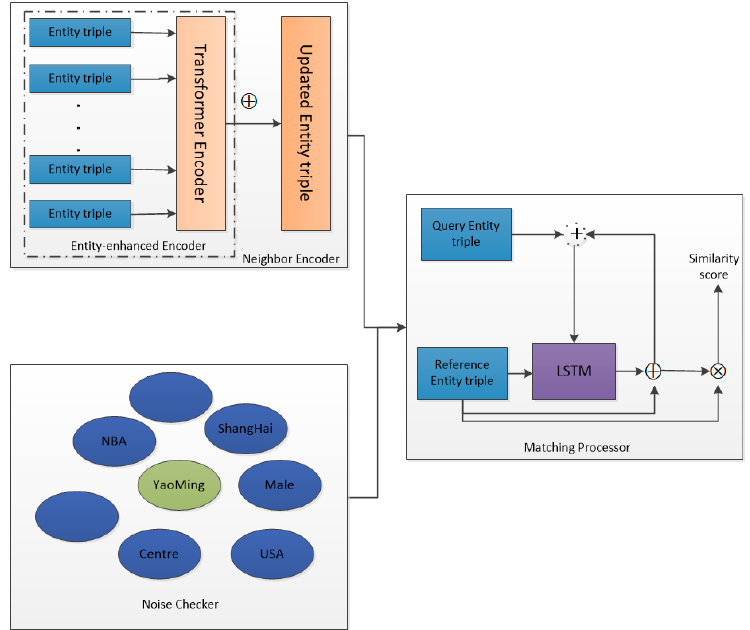
Figure 2. Overview of the AAF framework.